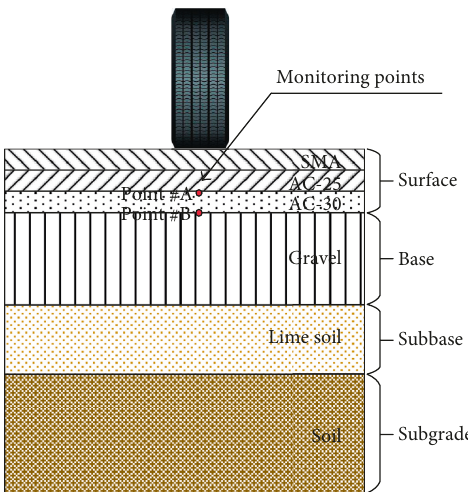
Figure 7: The monitoring points on the transverse section of the model